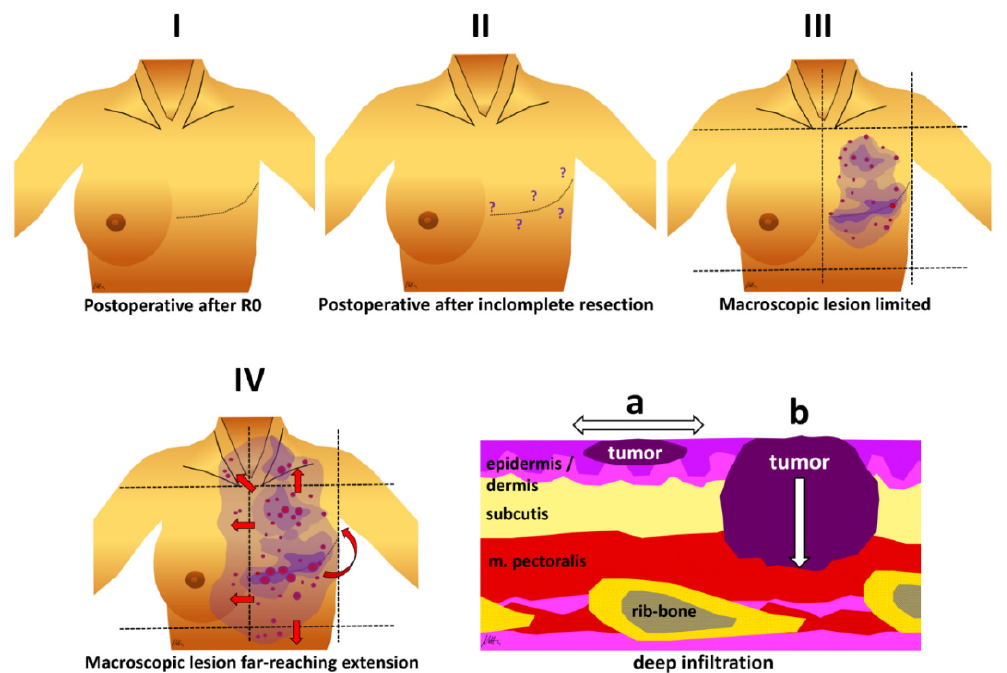
Figure 1. Different RAASB categories as used in this retrospective study. I = postoperative after R0, II = postoperative after incomplete resection (inappropriate margin, R1, or R2 respectively), III = macroscopic lesion limited to ipsilateral chest wall, not surpassing midsternal and midaxillary line, clavicle and lower costal margin, IV = macroscopic lesion with far-reaching extension, more than ipsilateral chest wall and supraclavicular fossa and/or contralateral chest wall or breast and/or abdominal wall and/or extension on the back. Lower right panel: Additional information on infiltration depth: a = infiltration limited to skin/subcutis, b = deep infiltration into muscle